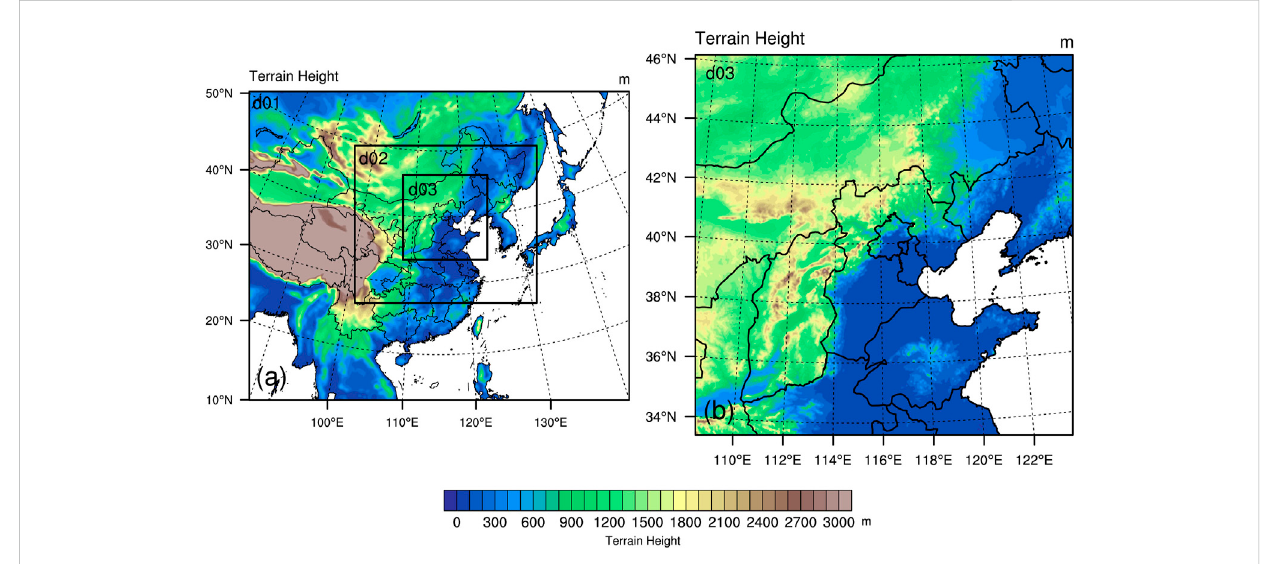
FIGURE 1 The topography (shaded; m) of (A) the triply nested weather research forecasting (WRF) simulated domains and (B) the fi nest domain